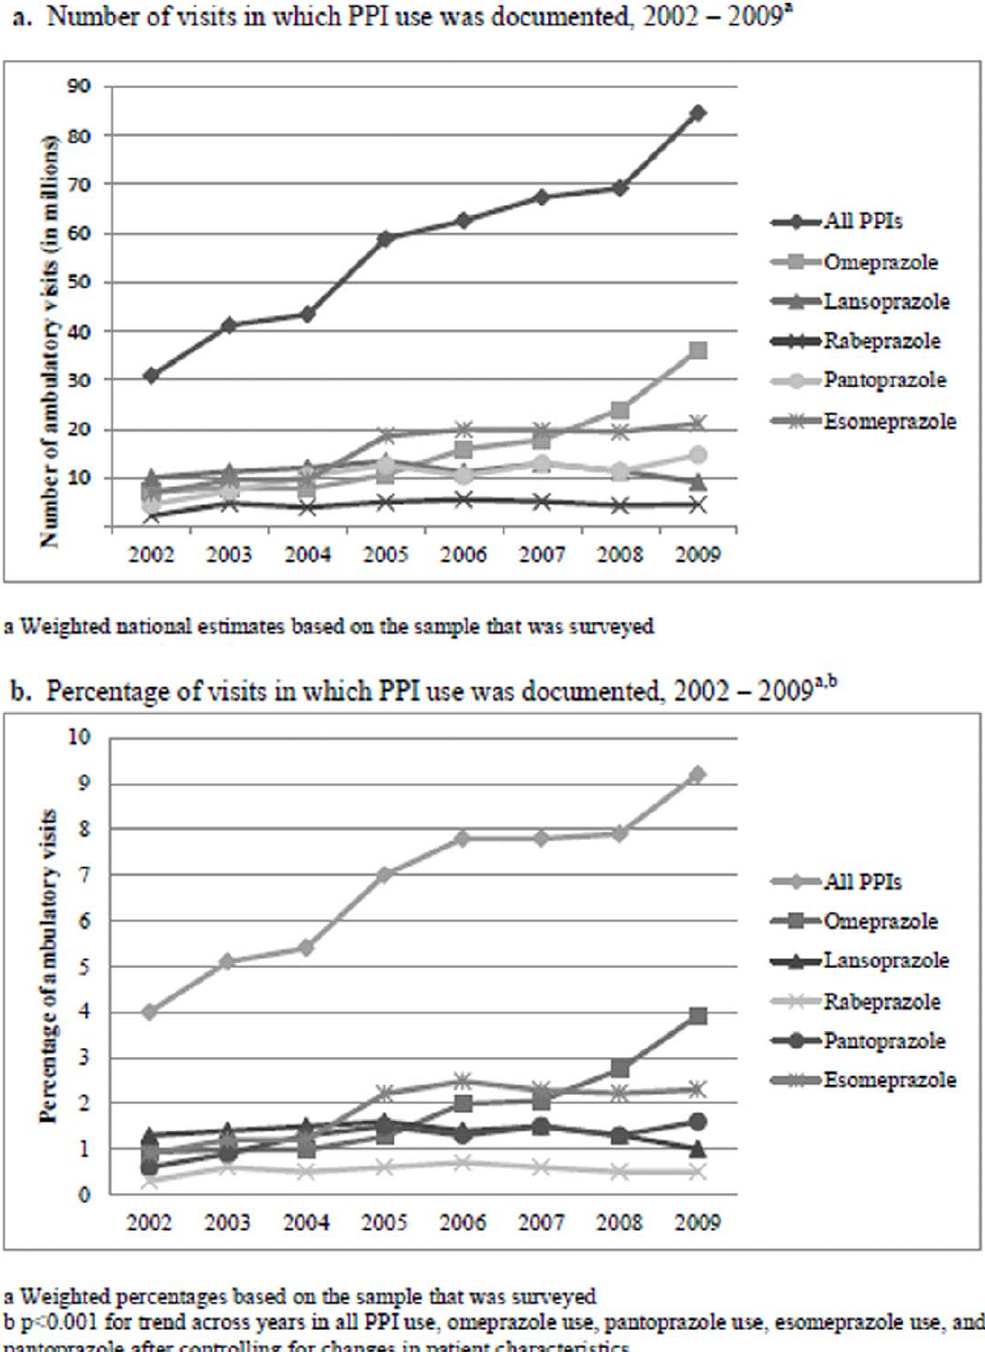
Figure 1. Changes in PPI use, 2002–2009.